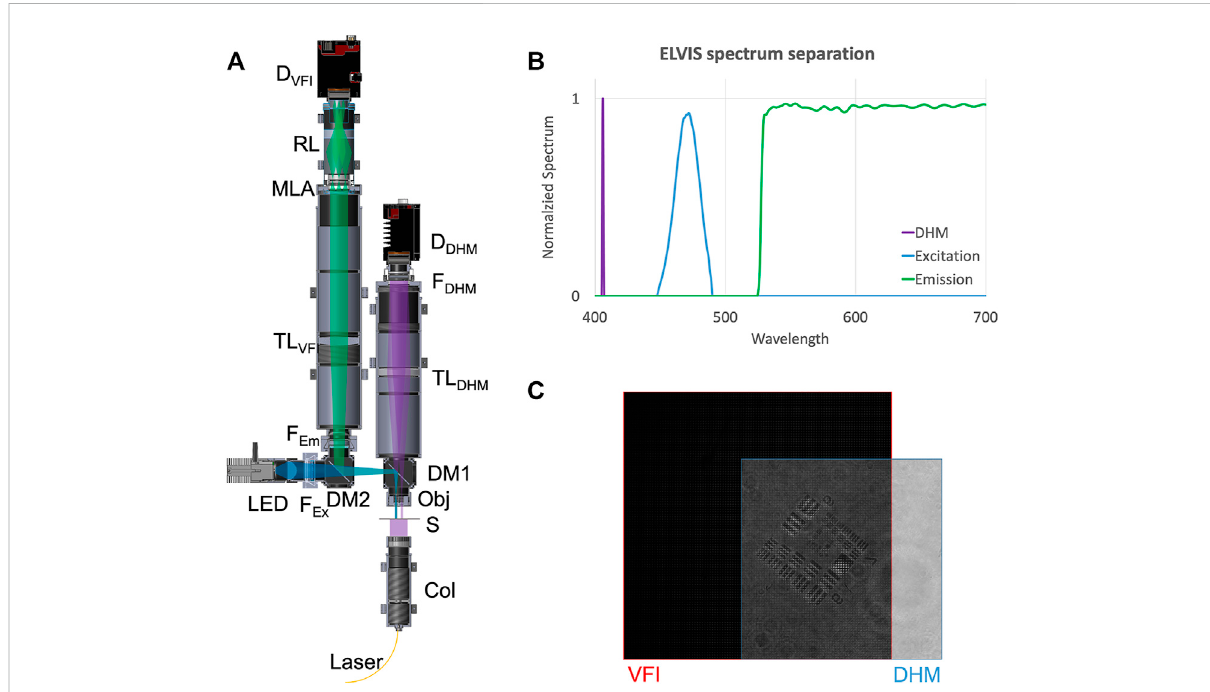
FIGURE 1 Combined DHM-VFI system. (A) Schematic of the combined system. Laser: Thorlabs S1FC405; Col: Laser collimator; S: Sample;Obj:Objective lenses (Edmund Optics, #47-689); DM1: Dichroic mirror (Thorlabs, DMSP425R); TL DHM : 150 mm tube lens (Thorlabs, AC508-150-A); F DHM : 405 nm spectral fi lter (Thorlabs, FB405-10); D DHM : DHM detector (Allied Vision, Prosilica GT 2450); LED: LED source (Thorlabs M470L3); F Ex : Excitation fi lter (Thorlabs, MF469-35); DM 2 : Dichroic mirror (Thorlabs, DMSP490R); F Em : Emission fi lter (Thorlabs, FELH0500); TL VFI : 200 mm tube lens (Thorlabs, AC508-200-A); MLA: Microlens array (RPC Photonics, MLA-S125-f30); RL: 0.528X Relay lens array (Opto Engineering, OPTC23016); D VFI : VFI detector (Allied Vision, Prosilica GT 2450). (B) Theoretical spectrum separation between DHM, VFI excitation and VFI emission. (C) Shared FOV between DHM and